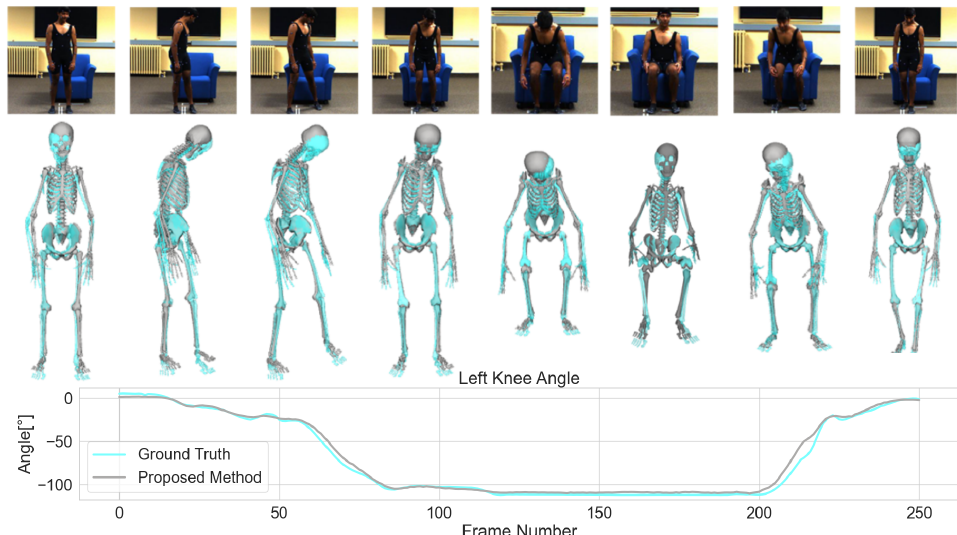
Figure 5. Qualitative results of D3KE from a ’sitting-down’ movement in the BML-Movi dataset. The top row shows selected frames throughout the movement. The middle row shows different poses of the ground truth skeletal model throughout the movement (cyan) and the skeletal model (white) based on D3KE’s estimation. The bottom row shows the changes in flexion/extension of the left knee throughout the movement with blue being the predicted and orange being the ground truth